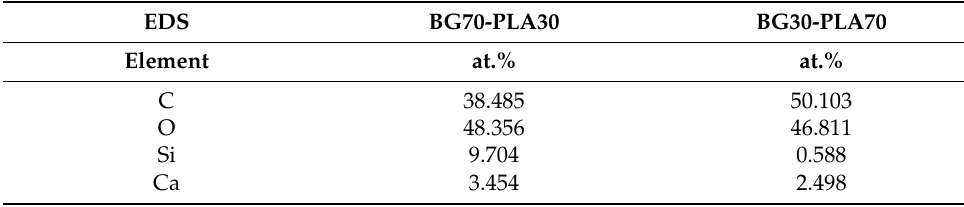
Table 3. Energy-dispersive X-ray spectroscopy for both compositions.